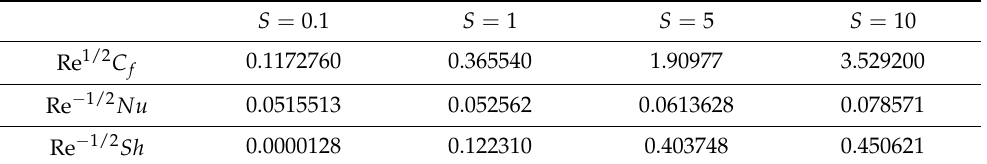
Table 3. Numerical outcomes for drag force and the heat and mass transfer rate with disk fluctuation, keeping [26] K vs = 0.5, λ = 0.5, Ω = 0.1, Sc = 1,Pr = 1, α = 0.5, K s = 0.5, K c = 0.5. S = 0.1